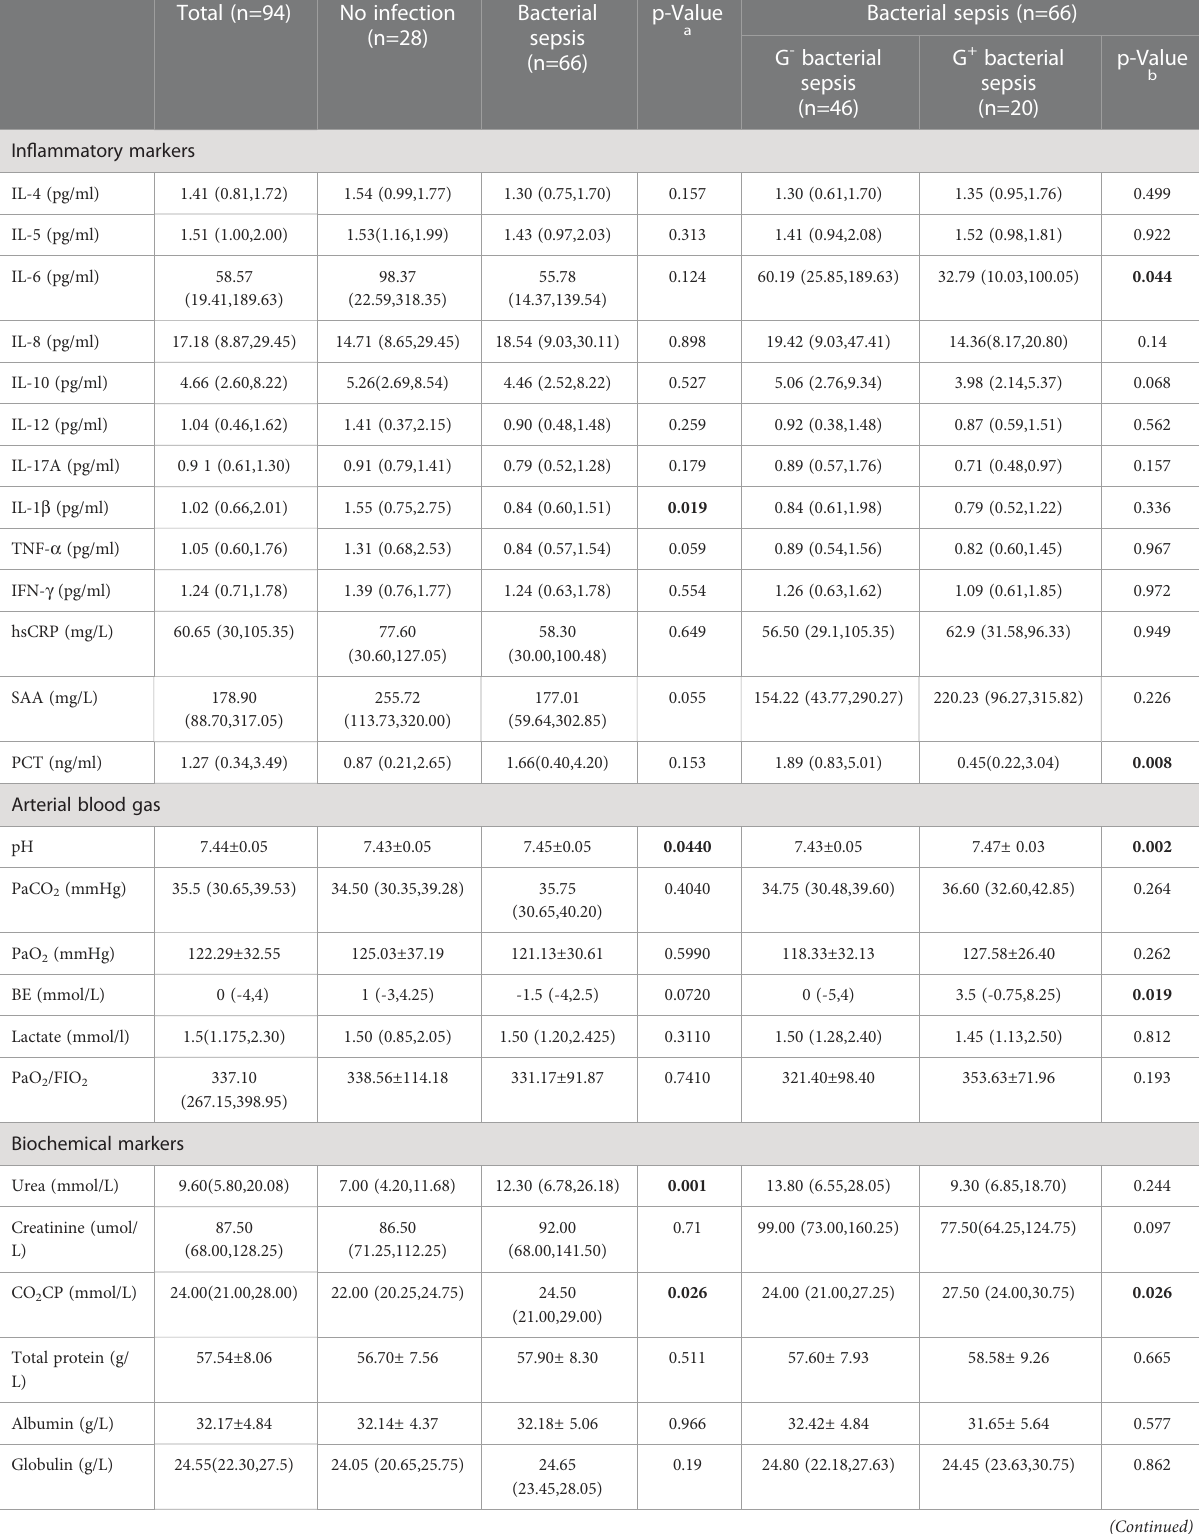
TABLE 3 In fl ammatory markers and other markers of critically ill